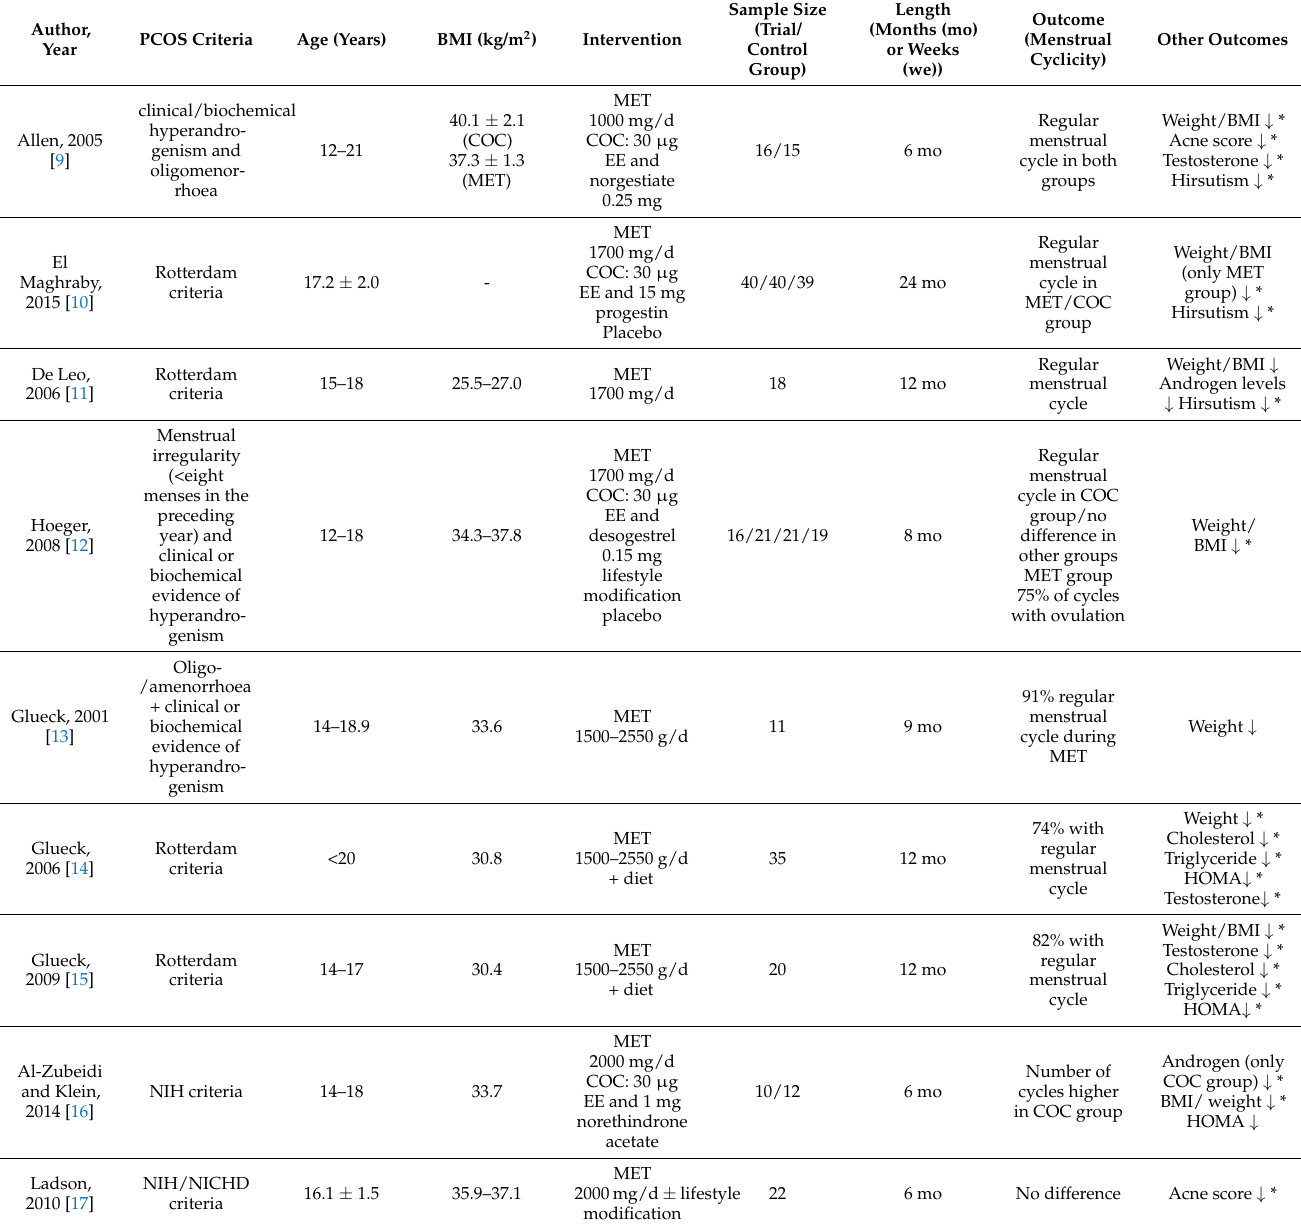
Table 1. Included Literature. (Abbreviations are explained